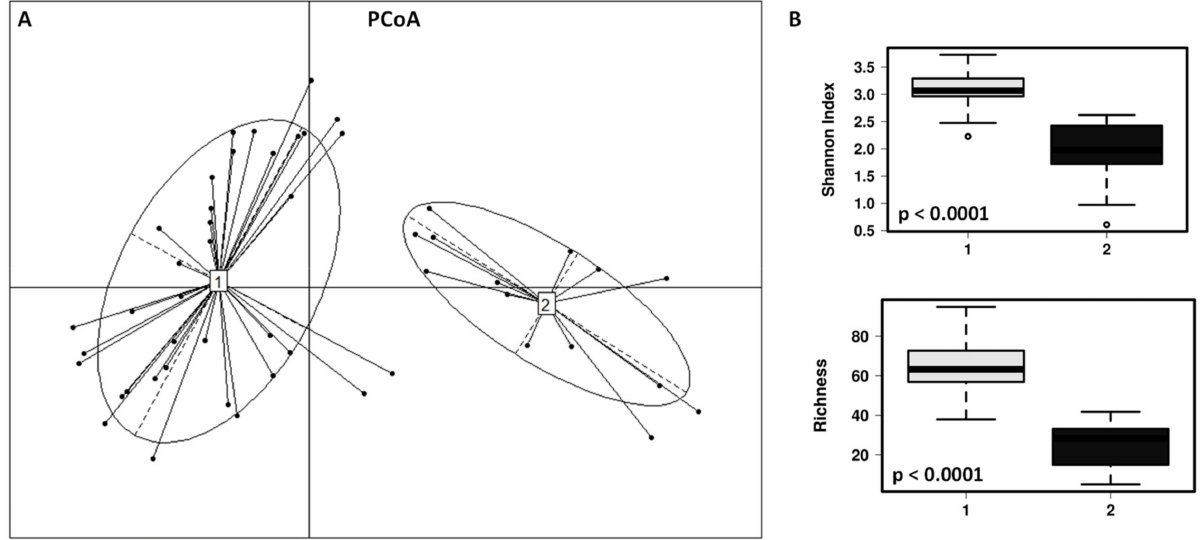
Figure 3. ( A ) Principal coordinates analysis (PCoA) showing the cluster of the fecal microbial populations in two different enterotypes (1—grey and 2—black). ( B ) Box and whisker plots showing significant differences after ANOVA analysis in fecal microbial diversity (Shannon index) and richness at the ASVs level in the comparison of the enterotypes 1 and